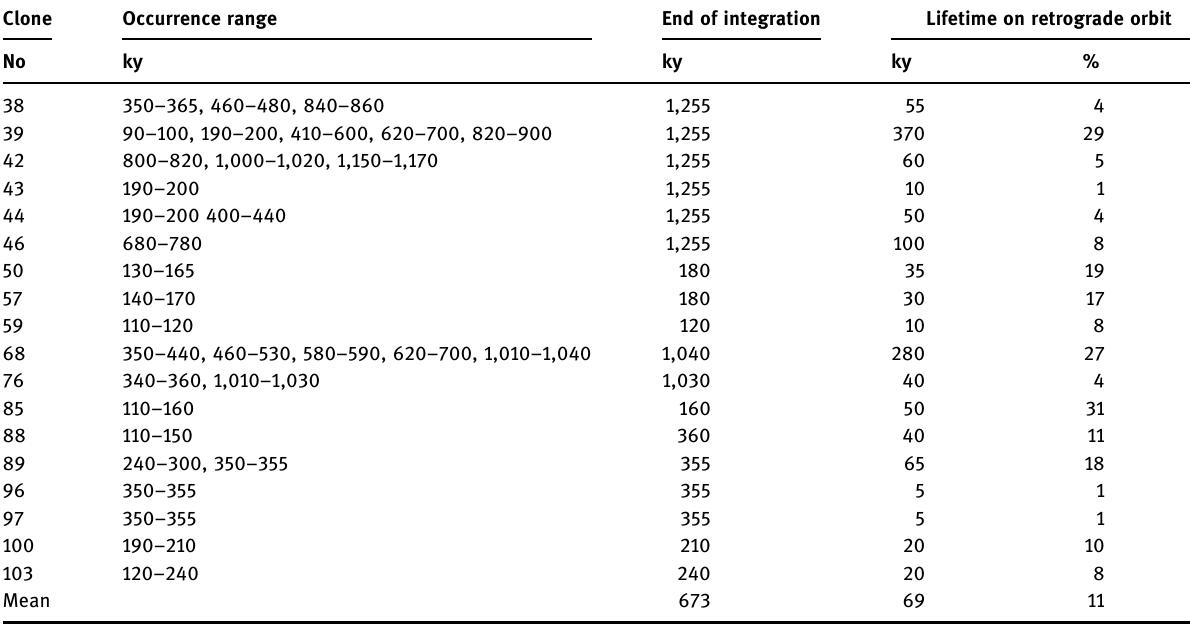
Table 5: Forward integration without NG e ff ects, the lifetime of clones in a retrograde orbit